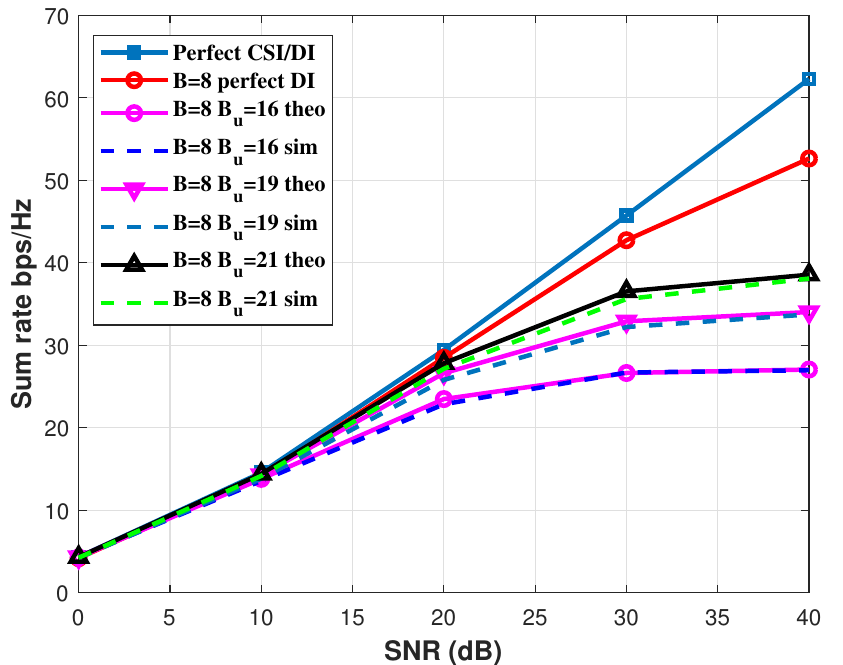
Figure 13. Performance comparison of theoretical and simulation results with SQ-based CSI feedback and RVQ-based DI feedback with different quantization bits in ( 3 × 3,1 ) 5.